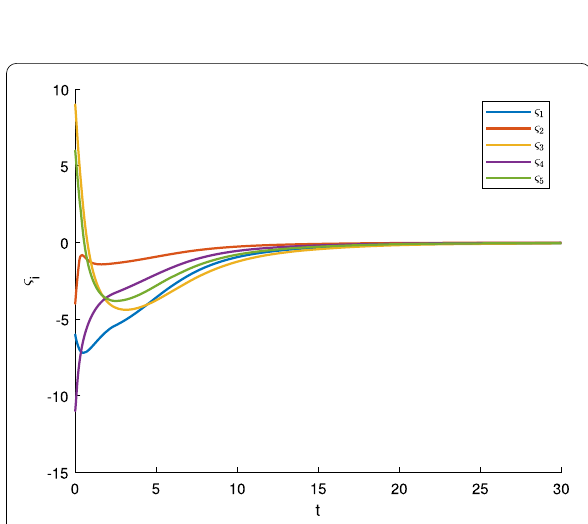
Figure 5 The output power trajectories of generator systems (33a)–(33b) under the algorithm (13) in [4]